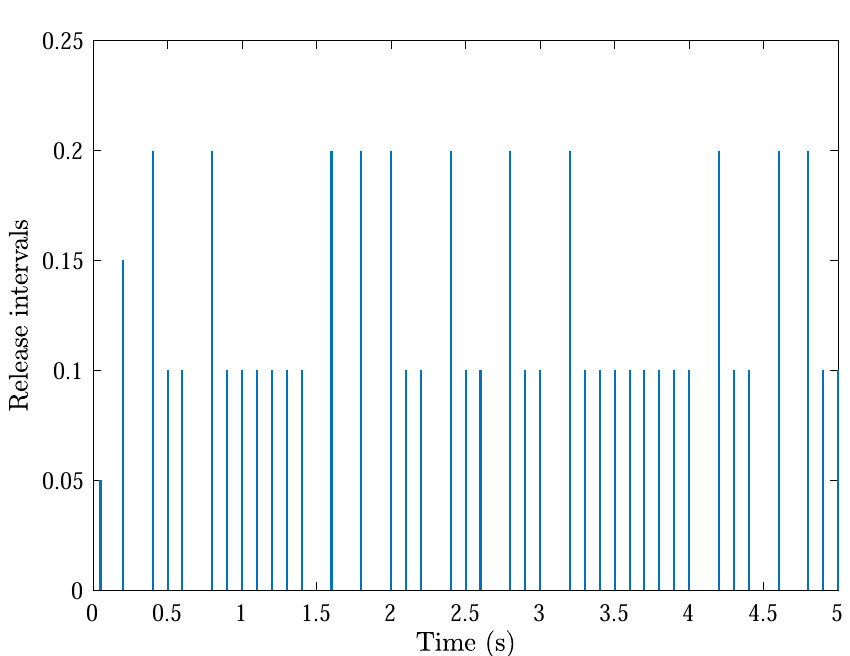
Figure 6. Event-triggered communication instants and release intervals of UAV 3.